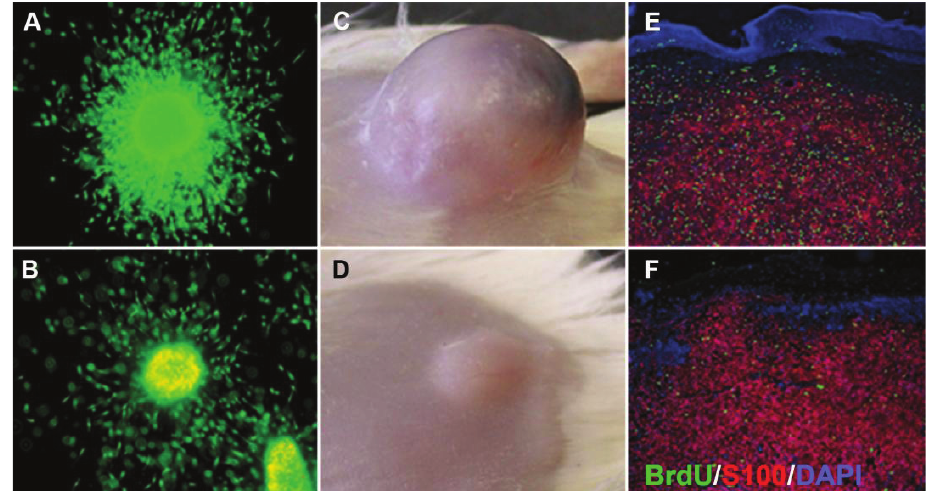
Figure 5. Comparison of 3D melanoma spheroid and xenograft. ( A ) Untreated spheroid; ( B ) spheroid treated with 10 μM selumetinib (MEK1/2 inhibitor AZD6244; Astra Zeneca) and stained with a live/dead assay (green: calcein-AM, live; red: ethidium bromide, dead). Note growth and invasion inhibition as well as increased cell death in the treated spheroid; ( C ) Untreated xenograft; ( D ) xenograft after treatment with 50 mg/kg selumetinib. Note the growth inhibition of the treated tumor. Sections of an untreated ( E ) and treated ( F ) xenograft stained for BrdU (green; proliferation marker), S100 (red, used here as a melanoma marker), and DAPI (blue, nuclear marker) showing a decrease in BrdU uptake after selumetinib treatment. Figure adapted from Haass et al ., 2008